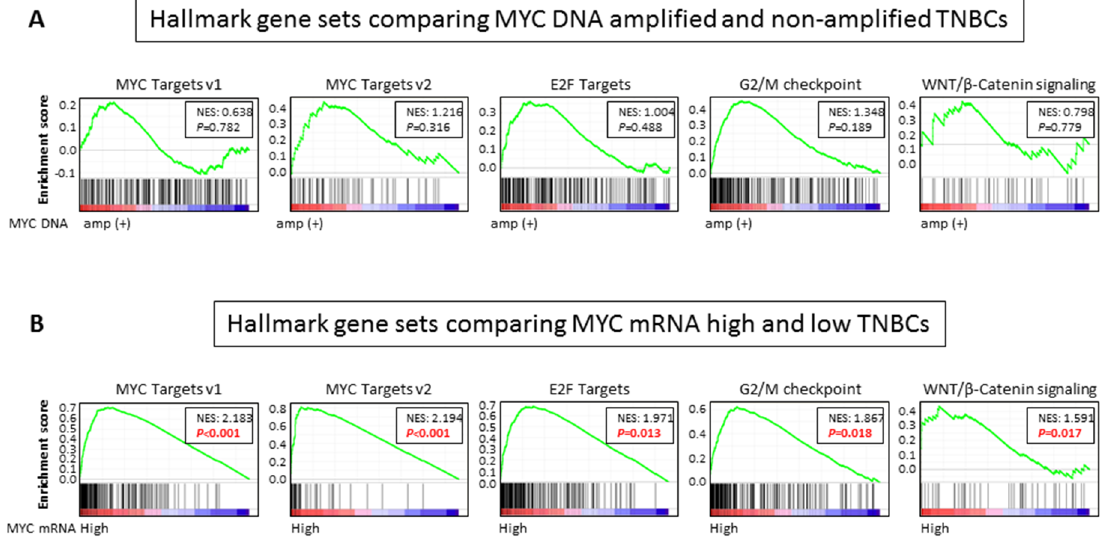
Figure 5. A Gene Set Enrichment Analysis (GSEA) comparing ( A ) MYC DNA amplified and non-amplified TNBCs, and ( B ) MYC mRNA high and low expressing TNBCs in TCGA.